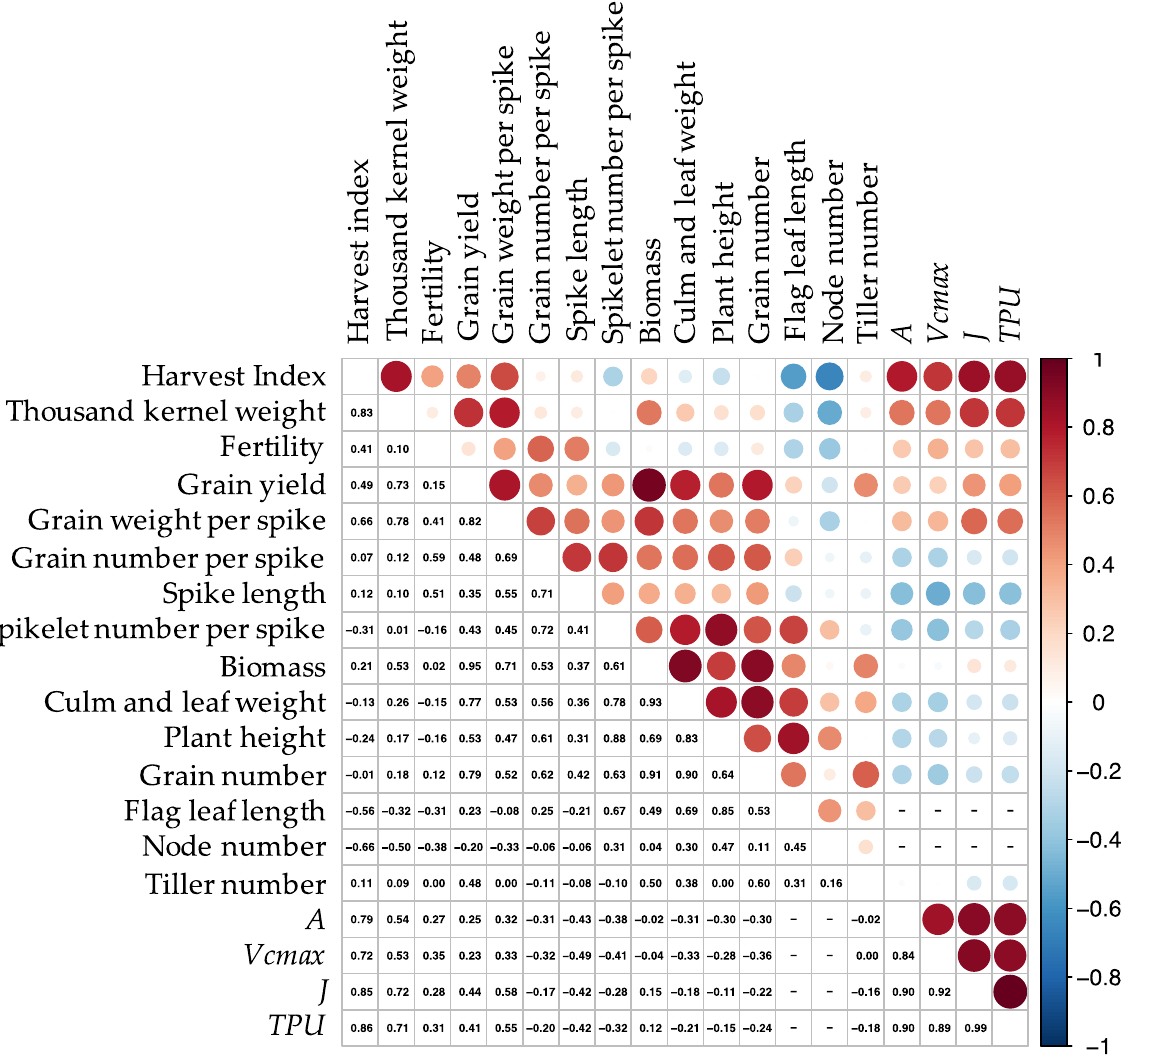
Figure 5. Heat map of correlation matrix of agricultural traits and physiological traits related to photosynthetic rate. Cor- relation coefficients were calculated without separating growing conditions. The strength of the correlation is indicated by the color, size, and intensity of each circle: red = positive, blue = negative; larger and darker = higher, smaller and lighter = lower. A , photosynthetic CO 2 assimilation; Vcmax , the maximum carboxylation rate of rubisco; J , the rate of photosyn- thetic electron transport; TPU , the triose phosphate utilization. Bar (-) indicates that the corresponding data do not exist.